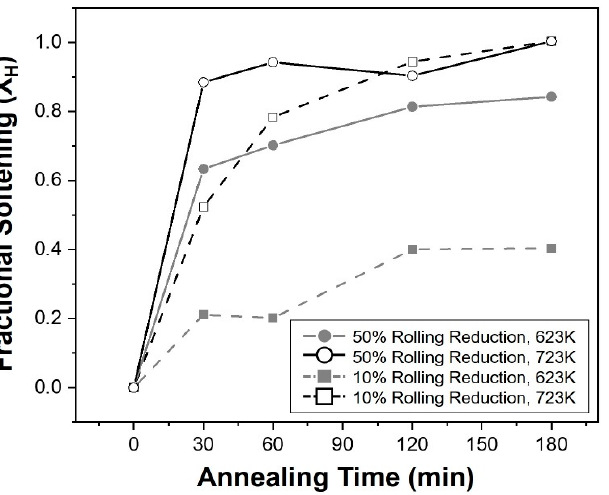
Figure 9. Graph showing the relationship between the fractional softening and annealing condition.